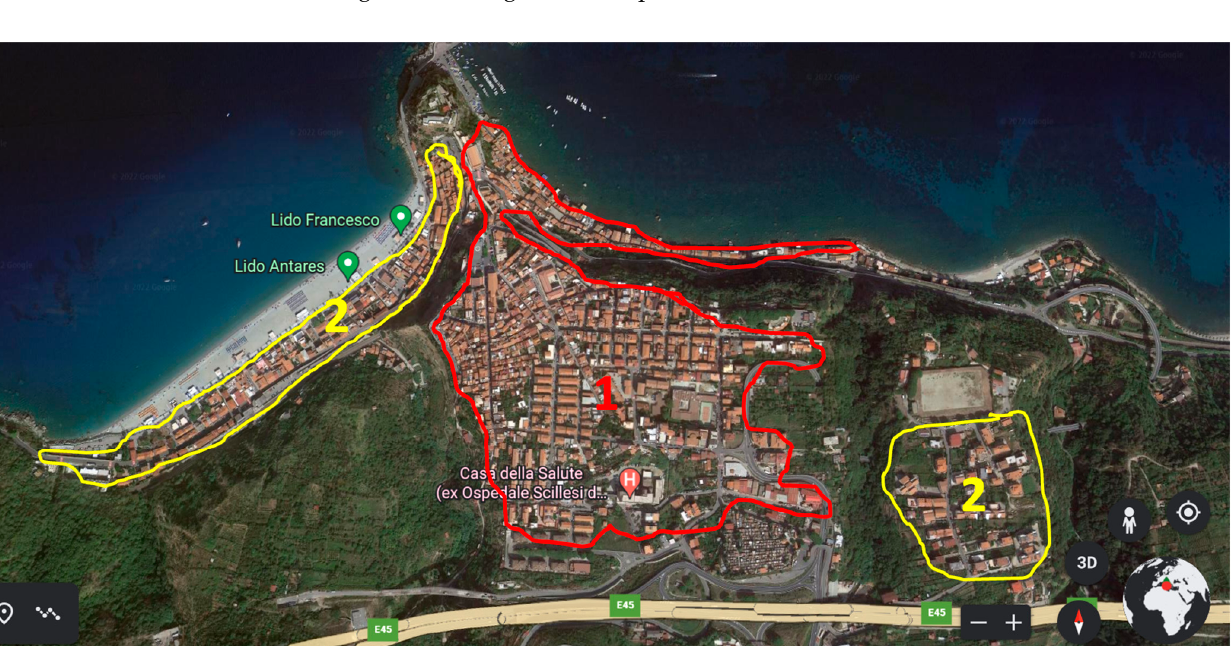
Figure 3. Historical maps made available by the Italian Geographic Military Institute (IGM). ( a ) Historical map of scilla dating back 1884. ( b ) Historical map of Scilla dating back 1959.